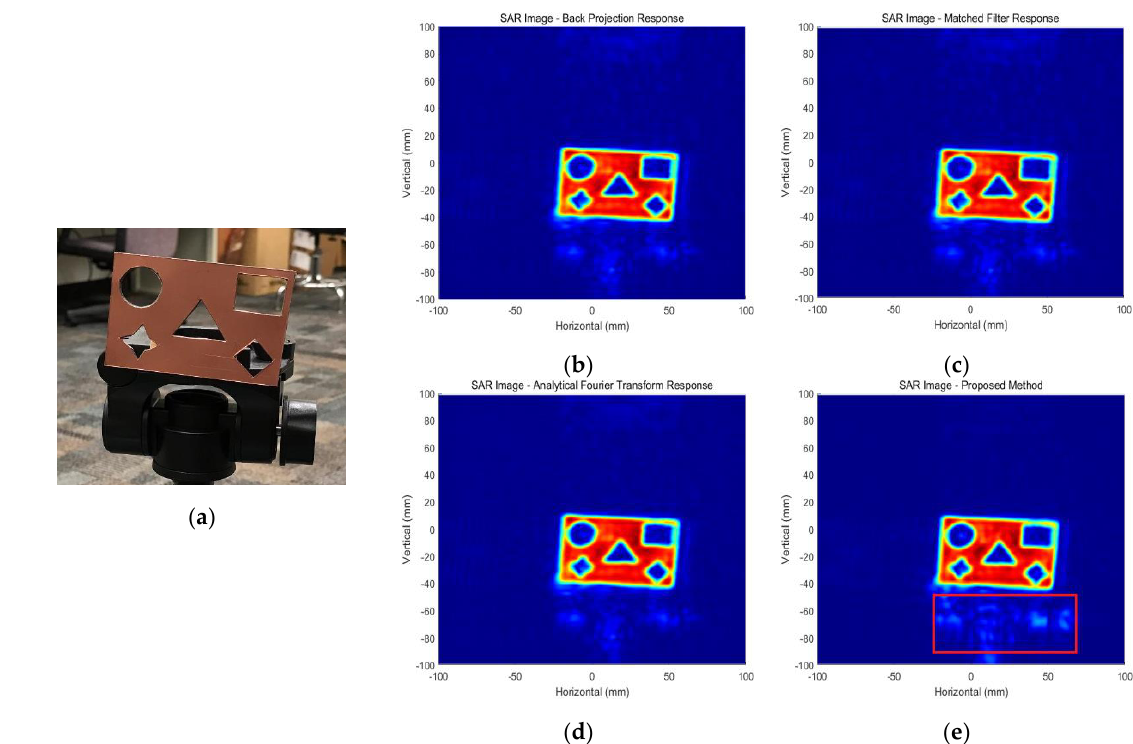
Figure 12. Different-Distance multiple targets: ( a ) scenario-1; ( b ) Back Projection; ( c ) Matched Filter; ( d ) Analytic Fourier Transform; ( e ) mmSight (red frame: projection of other target).